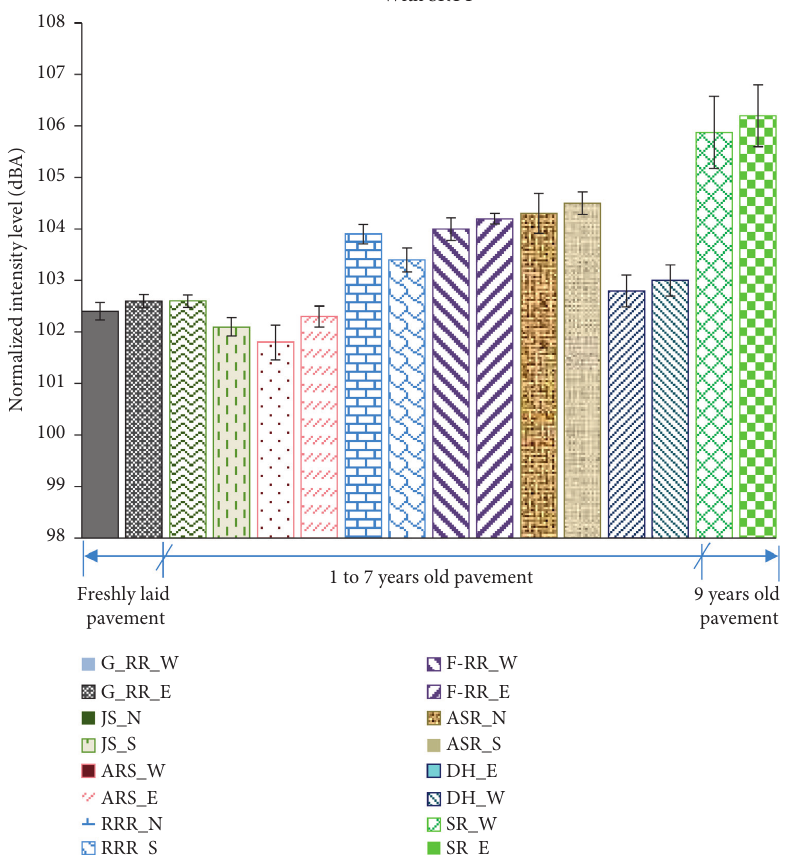
Figure 4: Normalized sound intensity level for DGA pavement surfaces in Qatar.